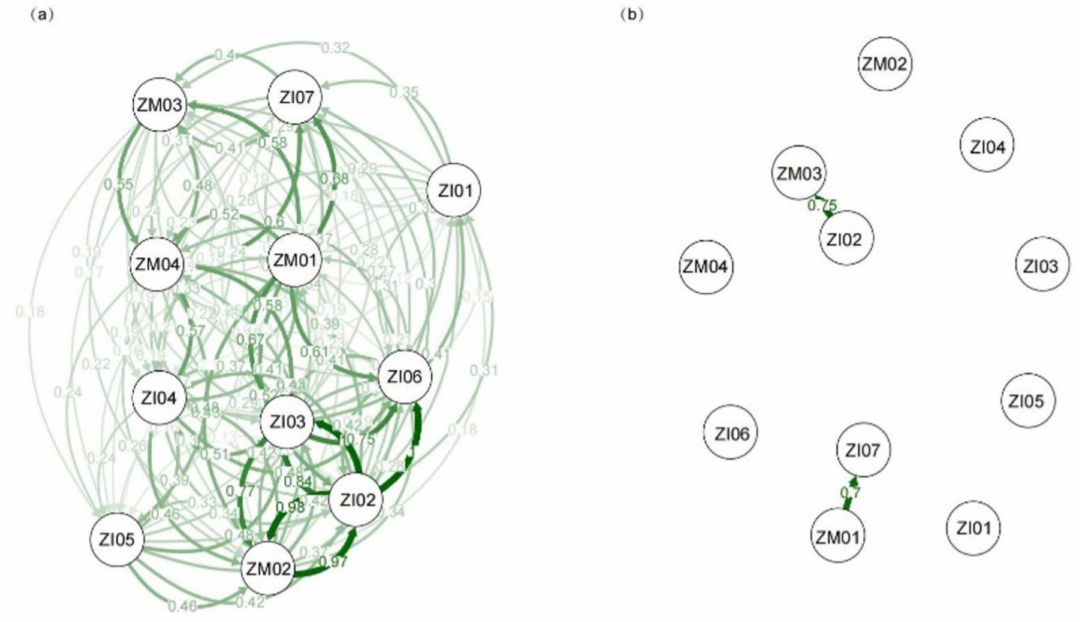
Figure 4. ( a ) The migration network among the 11 Hedyotis chrysotricha populations in the Zhoushan archipelago (ZA) region based on G ST (coefficient of gene differentiation) values and ( b ) significant relative migration relationships among populations (after 1000 bootstraps). Arrow thickness and color tone are proportional to the magnitude of the gene